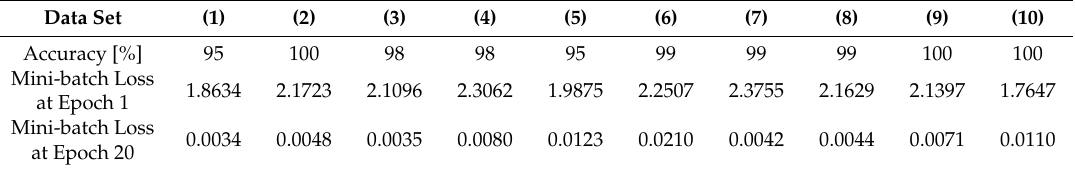
Table 6. The result of the 10-fold cross-validation, as shown in Figure 13.